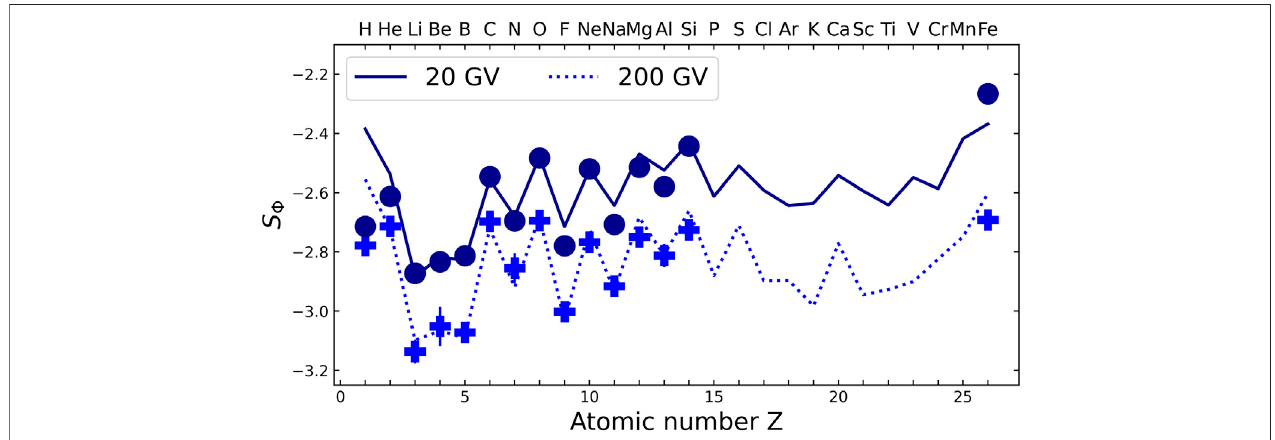
FIGURE 4 | Logarithmic slope at 20 GV (solid dark blue line) and 200 GV (dotted blue line) of our TOA fl ux calculation for Z = 1 − 26 elements. Slopes calculated from AMS-02 data points [1] are shown as symbols at the corresponding energies.